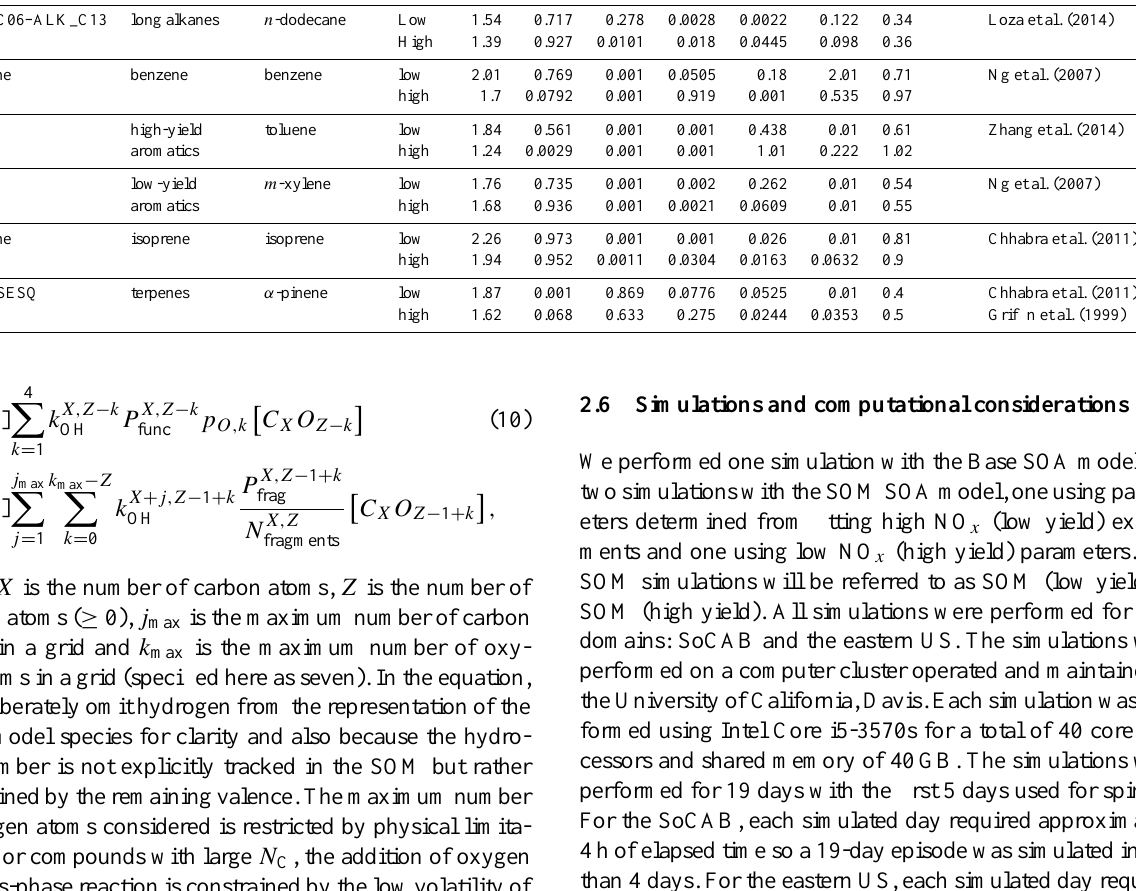
Table 1. SAPRC-11 model species, corresponding SOM grids, surrogate molecules, SOM parameters, O : C, and data source. SAPRC-11 species SOM Grid Surrogate to